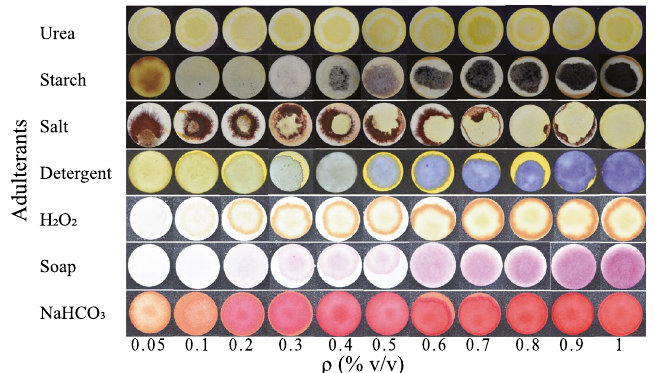
Figure 1. The change in color after the colorimetric reaction for different concentration of adulterants has been shown for all the